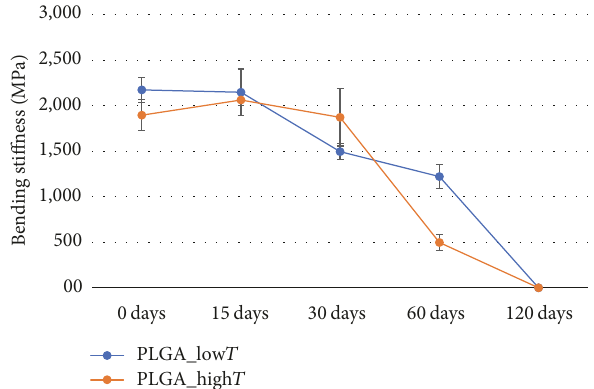
Figure 8: Bending stiffness along the hydrolytic degradation of PLGA low T and PLGA high T